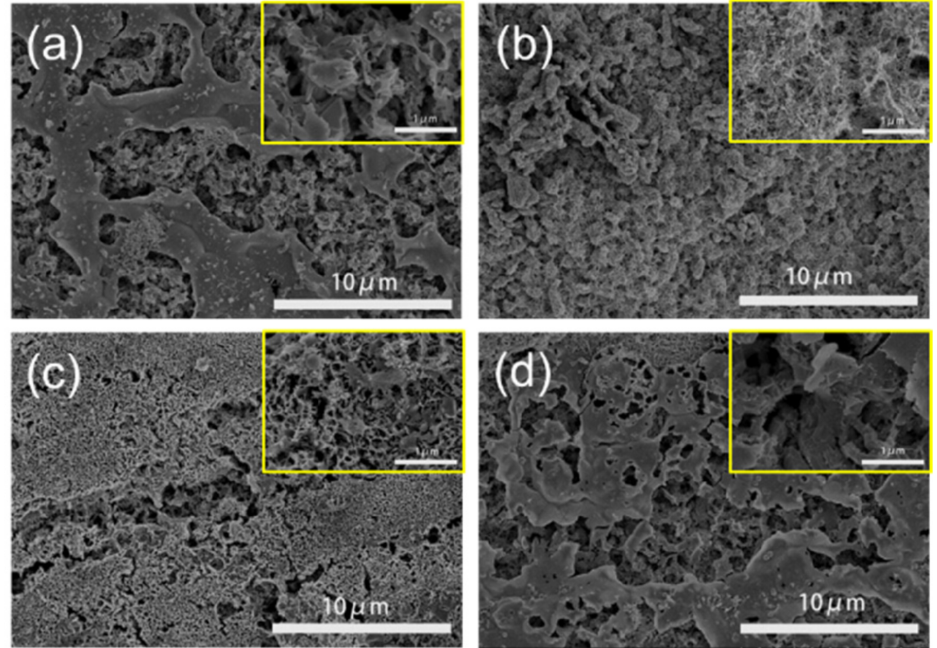
Figure 3. Scanning electron microscope (SEM) images of representative Zn electrodes: ( a ) Zn-N 2 , ( b ) Zn-CO 2 , ( c ) Zn-H 2 , ( d )